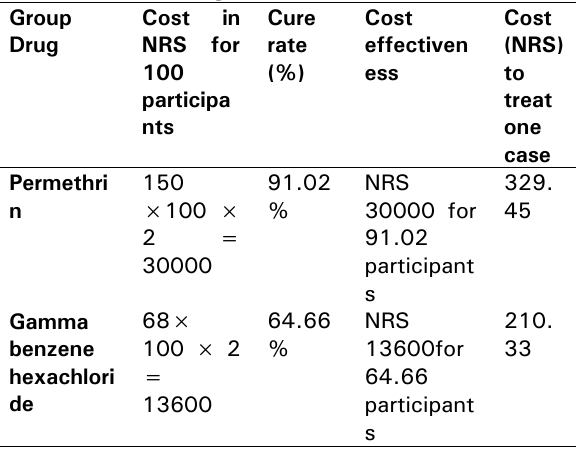
Table 4: Cost- effectiveness analysis of each drug at end of 2 weeks